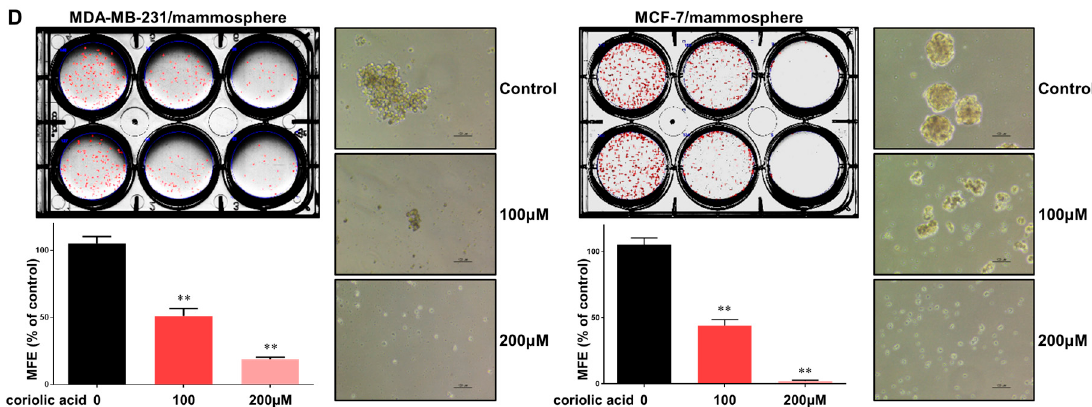
Figure 3. The effects of coriolic acid on cancer cell viability and mammosphere-forming efficiency. ( A ) MDA-MB-231, MCF-7, and HEK-293 cells were cultured with coriolic acid for 1 day. The cytotoxicity of coriolic acid was tested using the MTS assay. ( B ) Coriolic acid inhibits the colony formation of breast cancer cells incubated and treated with coriolic acid. ( C ) The effects of coriolic acid on the migration of breast cancer cell lines. Migrations with/without coriolic acid were imaged at 0 and 16 h (scale bar: 100 µm). The percent of inhibition in cell migration was expressed using untreated well at 100%. ( D ) Coriolic acid suppresses mammosphere-forming capacity. To make mammospheres, 0.5 × 10 4 MDA-MB-231 cells and 4 × 10 4 MCF-7 cells per well were plated in 6-well ultralow-attachment 6- well plates. The mammospheres were then cultured with coriolic acid. Representative mammospheres in the photos were obtained by inverted light microscopy (scale bar: 250 µm). The MFE was determined. Representative data were collected. The data from triplicate experiments are represented as the mean ± SD; * p < 0.005, ** p < 0.01.